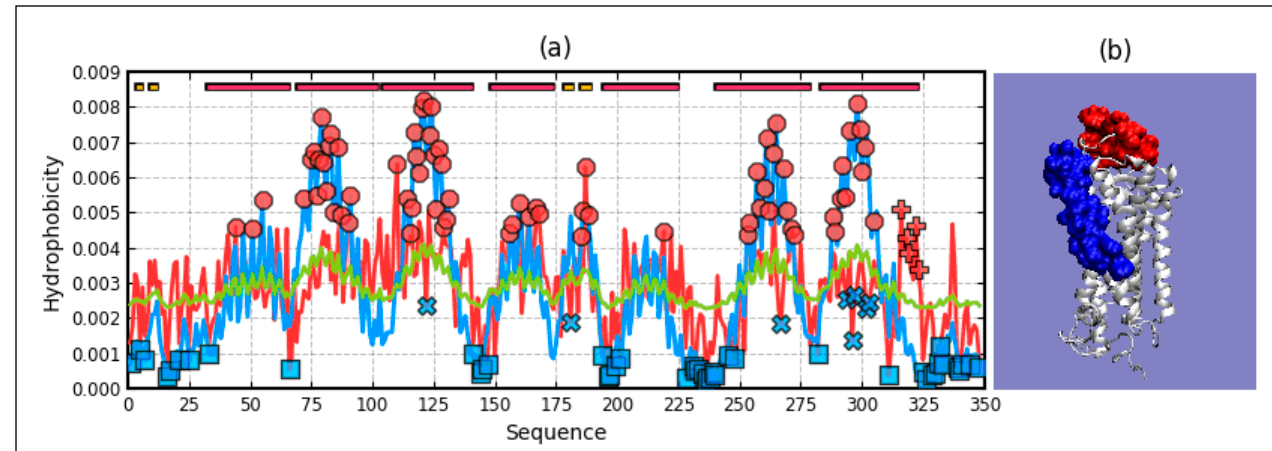
Figure 13. Characteristics of 1U19 ( a )—profiles T, O, and M in domains in 1U19-3D Gauss function generated for chain A Top bars: red—helix. Red circles—residues potentially engaged in hydrophobic core construction, blue “X”—residues of hydrophobicity deficiency—here residues engaged in channel construction, red “+”—hydrophobicity excess potentially engaged in protein-protein complexation—here—the interaction with membrane. The blue squares—residues on the surface representing low hydrophobicity—status accordant with FOD criteria. ( b )—3D presentation with residues distinguished—hydrophobicity deficiency (“X” on profiles)—blue, hydrophobicity excess (“+” on the profiles)—red. Colors are shown only for chain A.